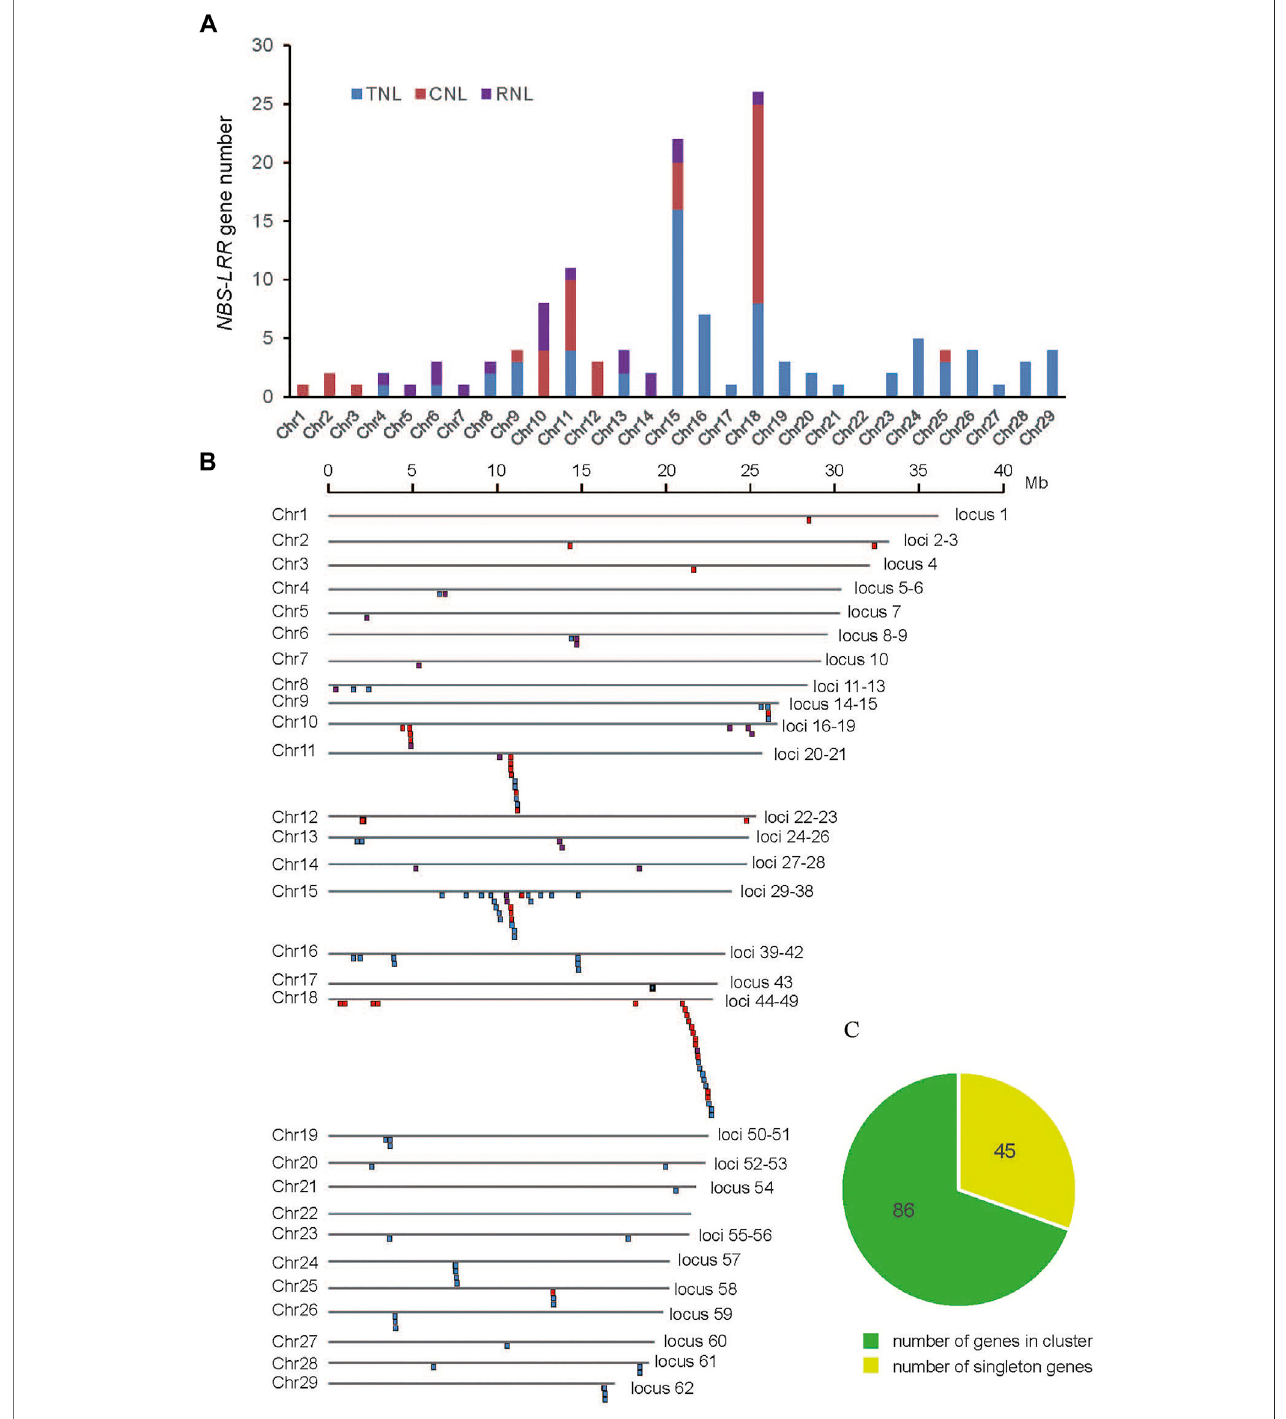
FIGURE2|(A) Thehistogram shows thenumber of NBS-LRR genesineach chromosome. (B) Chromosomaldistributionof E.feroxNBS-LRR genes. (C) The pie chart shows the proportion between singleton and clustered NBS-LRR genes.